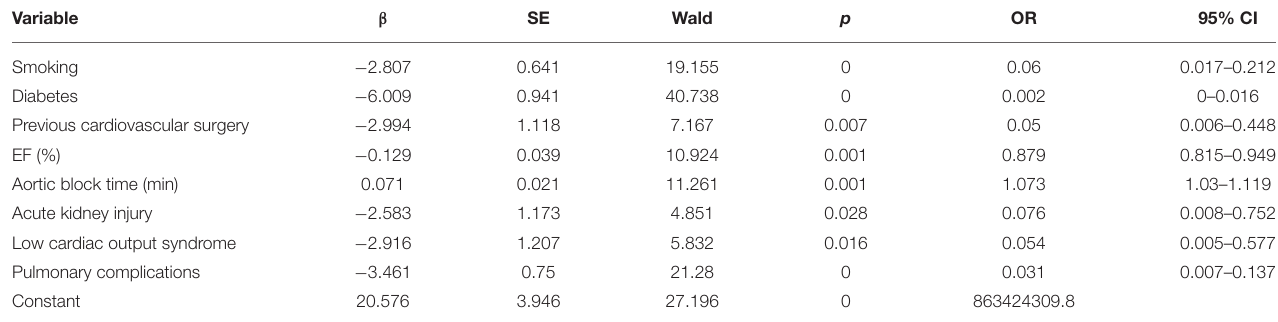
TABLE 3 | Logistic regression modeling ( n = 438).